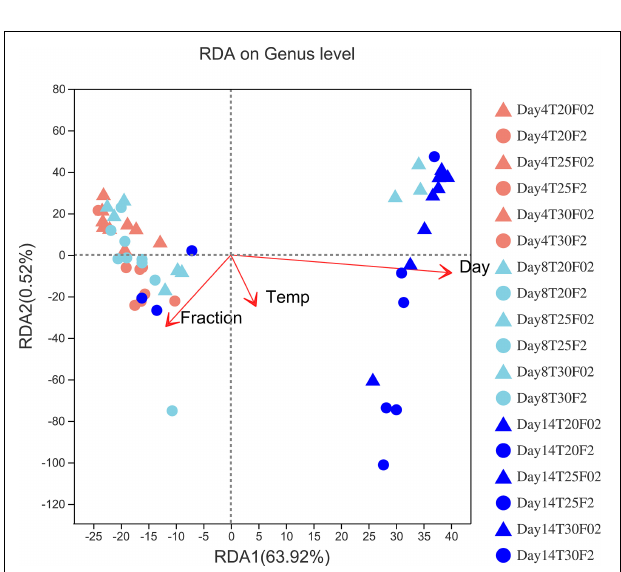
( Supplementary Table 3 ). Although the samples cultured